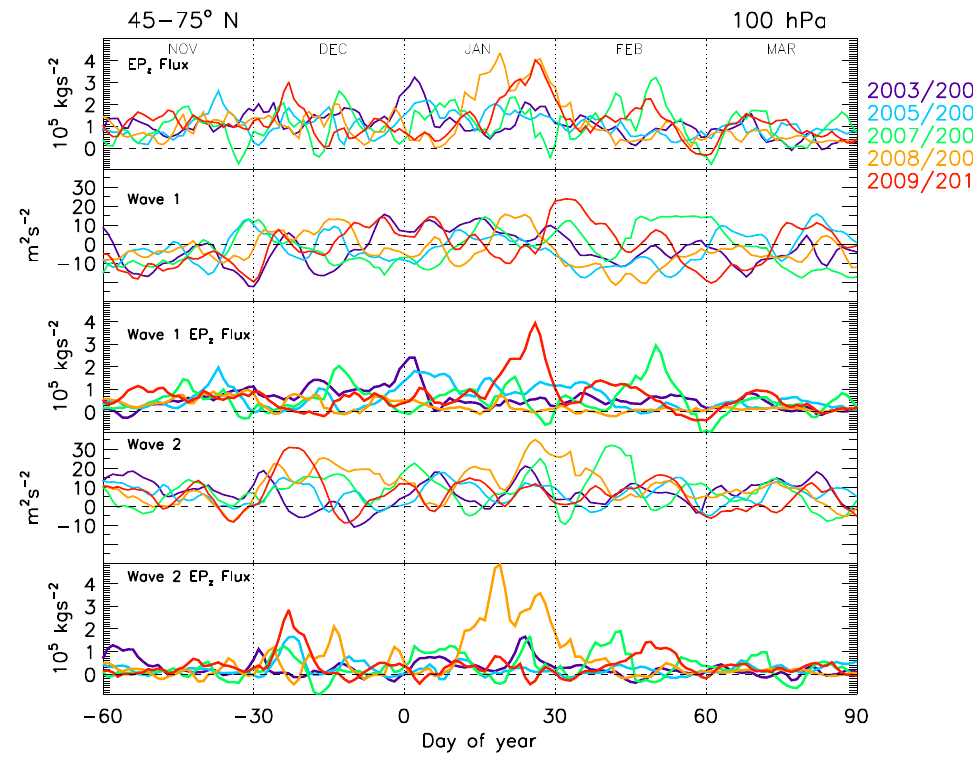
Fig. 6. Temporal evolution of various zonally averaged quantities (data: the ECMWF operational analysis) for selected Arctic winters at 45–75 ◦ N/100hPa. The quantity zero is marked with dashed horizontal lines and the dotted vertical lines separate each month.